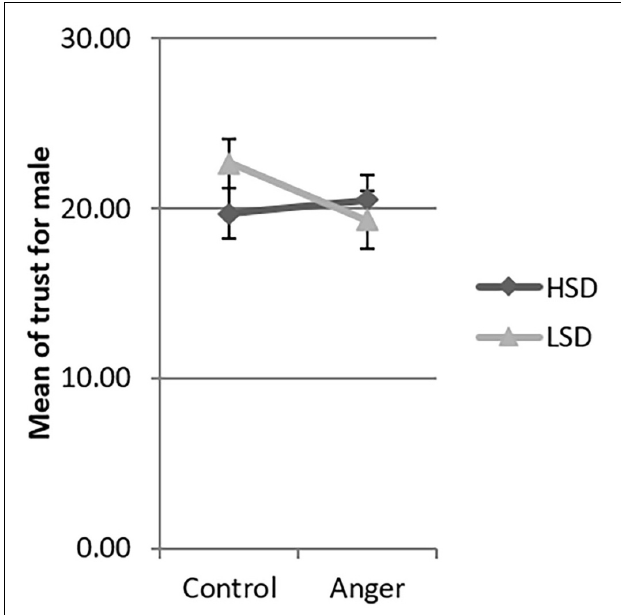
FIGURE 6 | Mean of trust of male across the four experimental conditions in Study 2. LSD, low social distance:; HSD, high social distance. Error bar is the standard